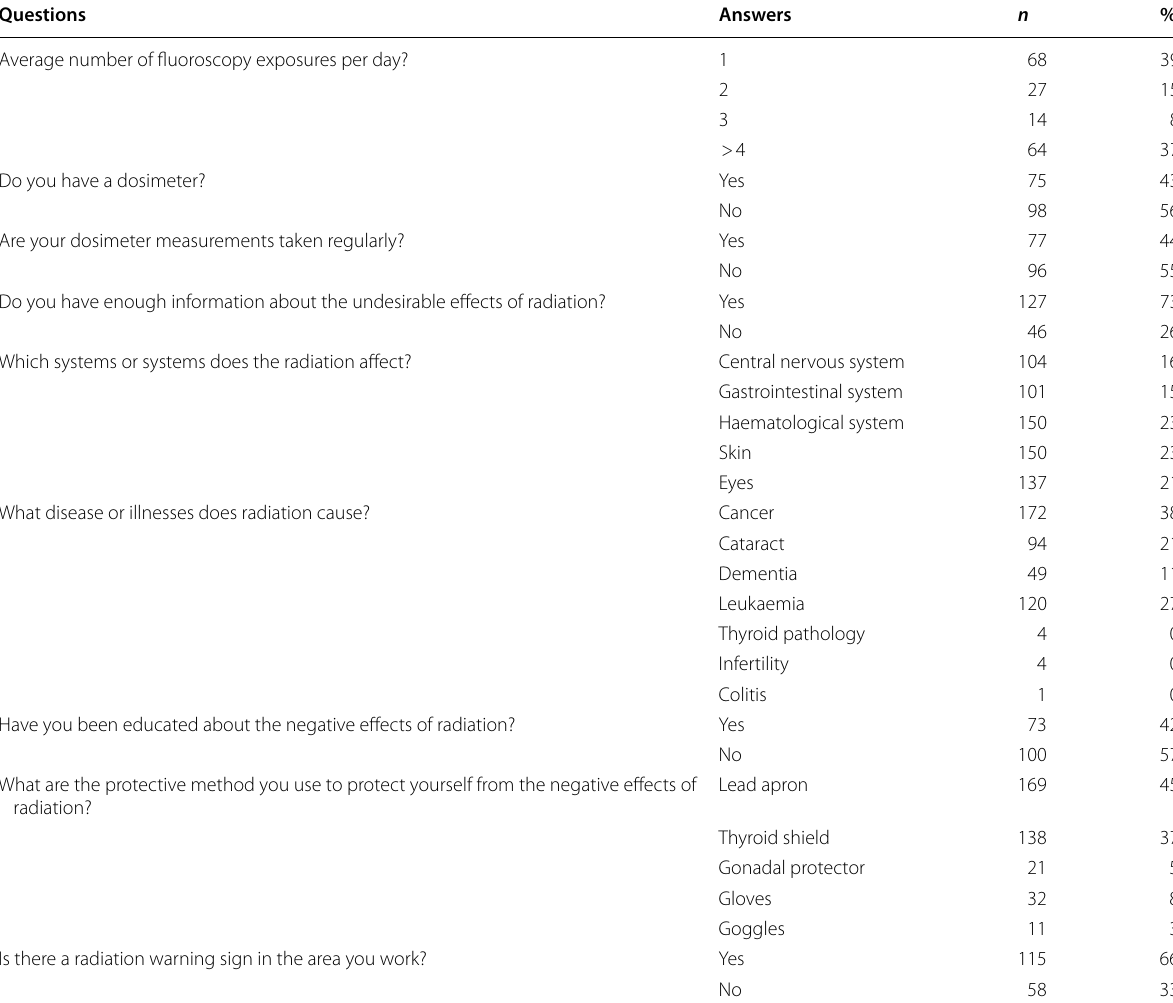
Table 2 Other questionnaire responses by